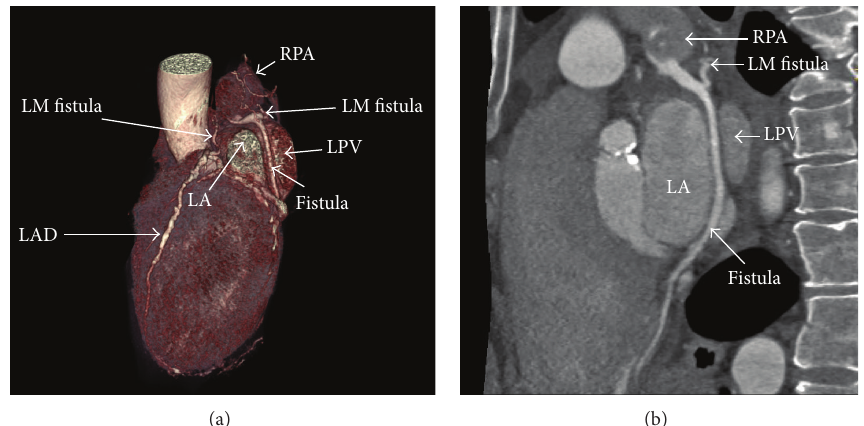
Figure 3: (a) Volume rendering CTA showed LM fistula joining the fistulous vessel of the other coronary arteries draining into the RPA. (b) Curved MPR showed the insertion point of the fistula at RPA. LAD: left anterior descending artery. LPV: left pulmonary vein. LA: left atrium.